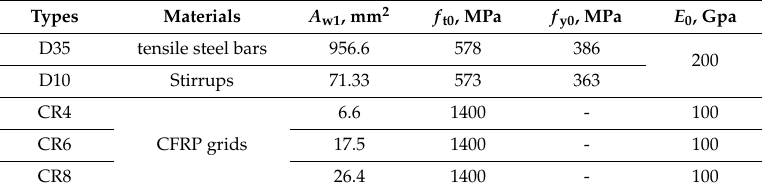
Table 7. Material properties of steel bars and CFRP grids.